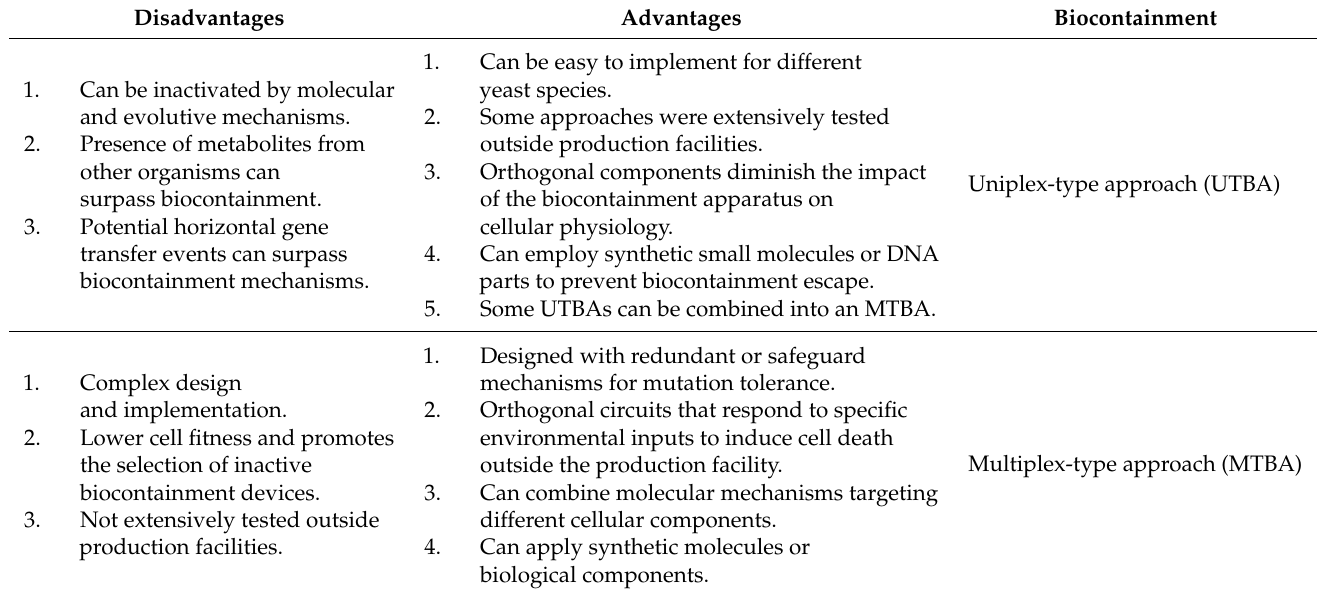
Table 1. Advantages and disadvantages of different biocontainment approaches for genetically modified